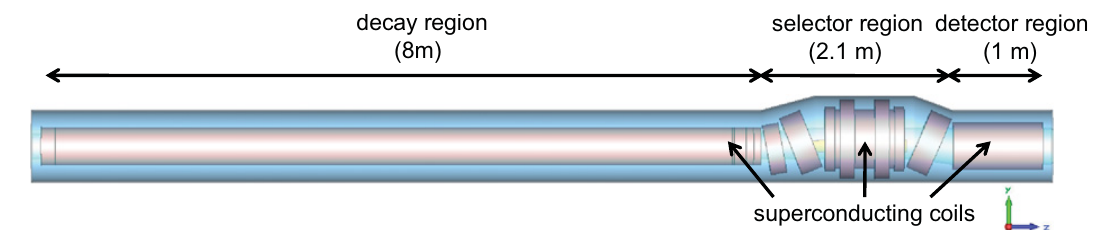
Figure 1. Sketch of the PERC magnet system. Three sections are identified: the long upstream solenoid contains the decay volume, the selector region contains the magnetic filter and separates charged decay products from the neutron beam, and the detector section contains detector systems or serves for transport to specialised spectrometers downstream.